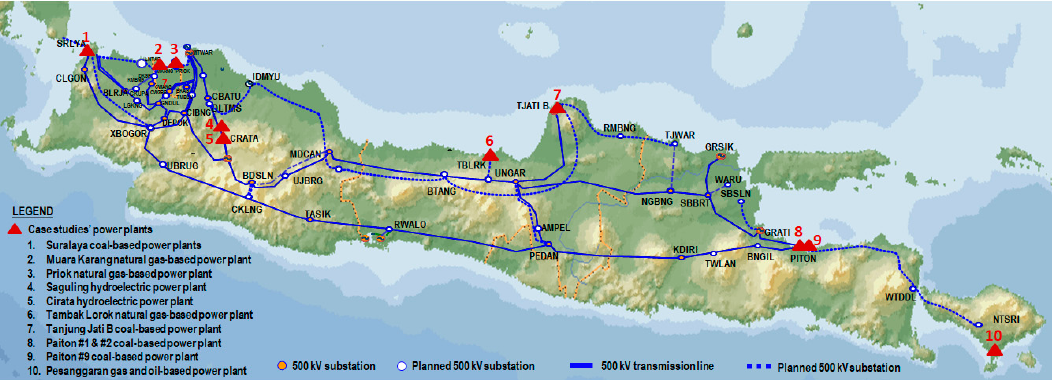
Figure 1. Power plants and extra-high-voltage Java-Bali transmission networks covered by this study, modified from [42]. While this figure depicts only the extra-high-voltage transmission networks, this study also includes high-voltage transmission networks and low-voltage distribution networks.